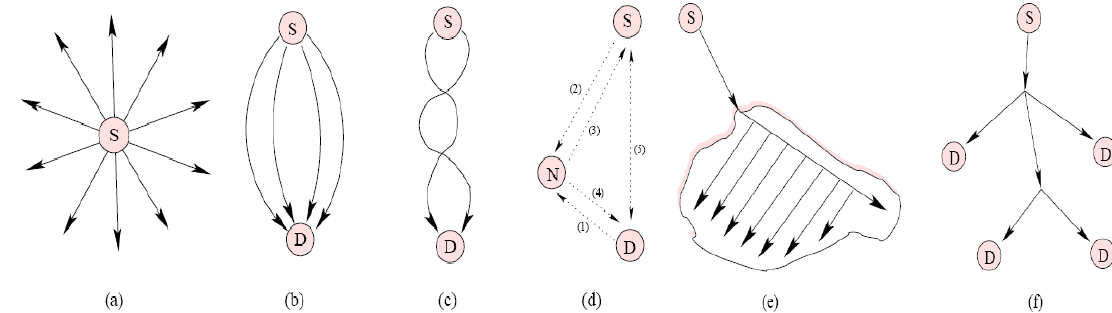
Figure 16. Applications of CBR